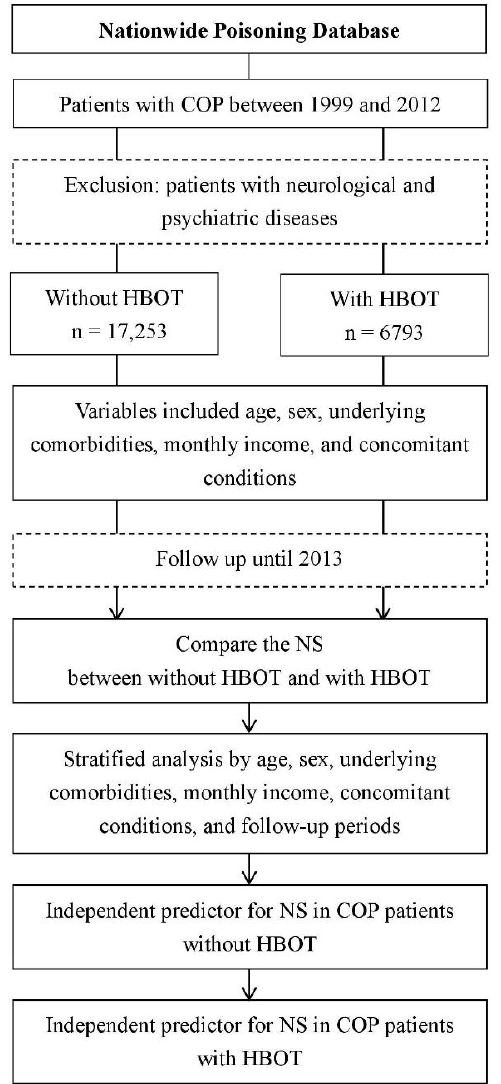
Figure 1. Flowchart of this study. COP, carbon monoxide poisoning; HBOT, hyperbaric oxygen therapy; NS, neurological sequelae.